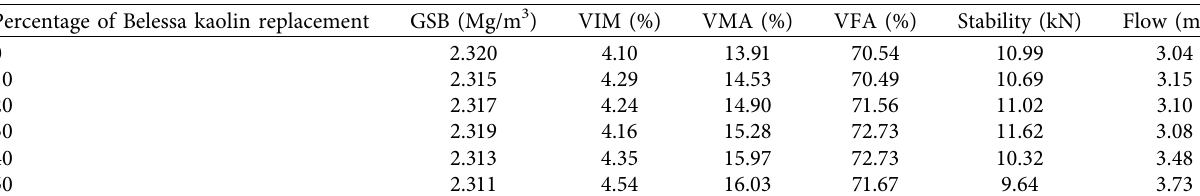
Table 9: Marshal properties at the diferent proportion of Belessa kaolin and CSD.